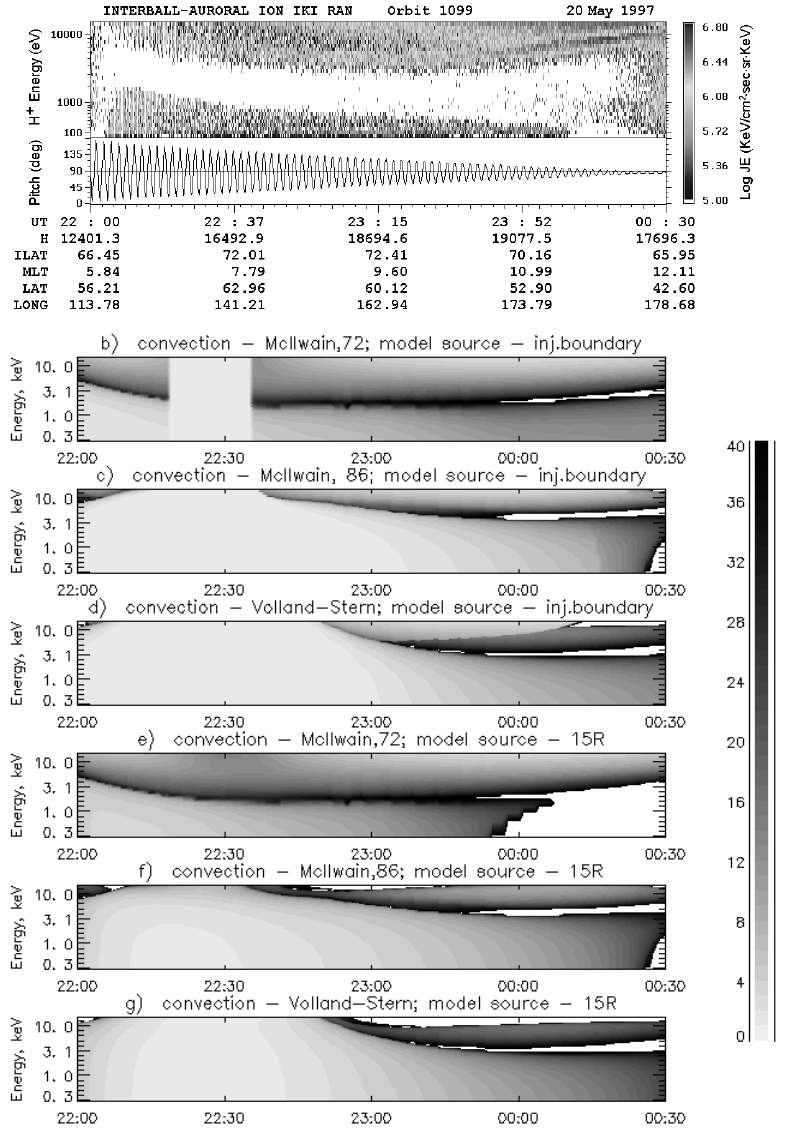
Fig. 8. Same as Fig. 7 for 20–21 May 1997 (orbit